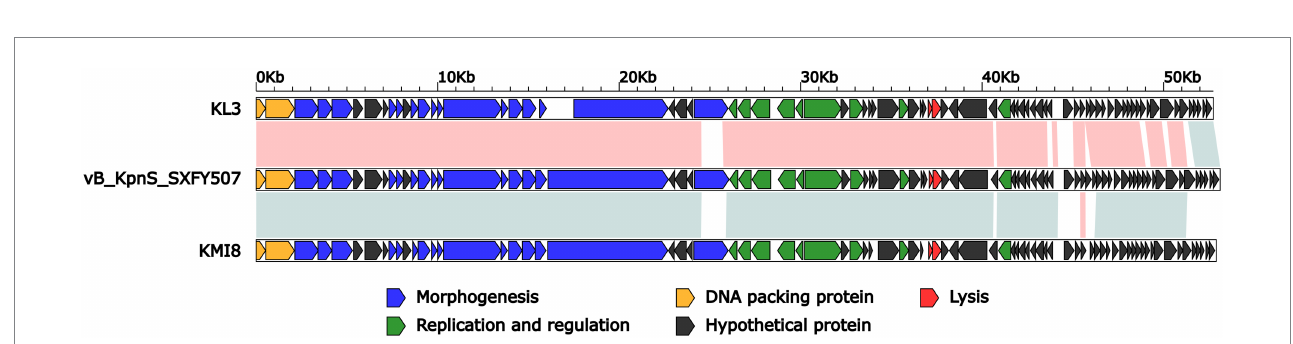
FIGURE 4 Linear comparison of the genomes of phage vB_KpnS_SXFY507, KL3 (GenBank accession number OK019720), and KMI8 (GenBank accession number MN101222). Genes are denoted by arrows. Genes are colored based on function classification (blue: morphogenesis; green: replication and regulation; orange: DNA packing protein; red: lysis; and black: hypothetical protein). Shading denotes regions of homology (red: >90% nucleotide identity; blue: >85% nucleotide